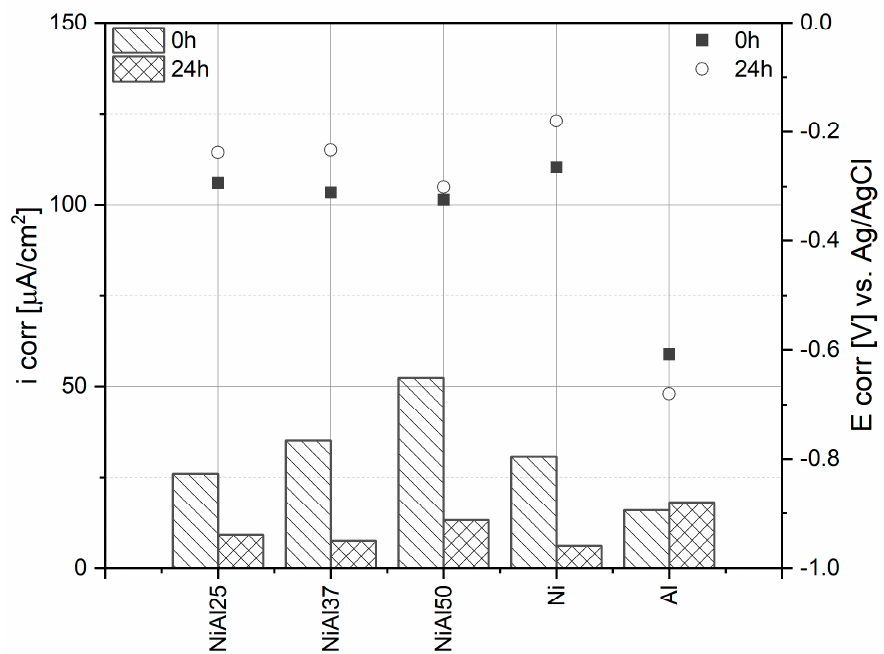
(Figure Figure 8. Corrosion current and corrosion potential of samples evaluated from polarization curves (Figure 7).